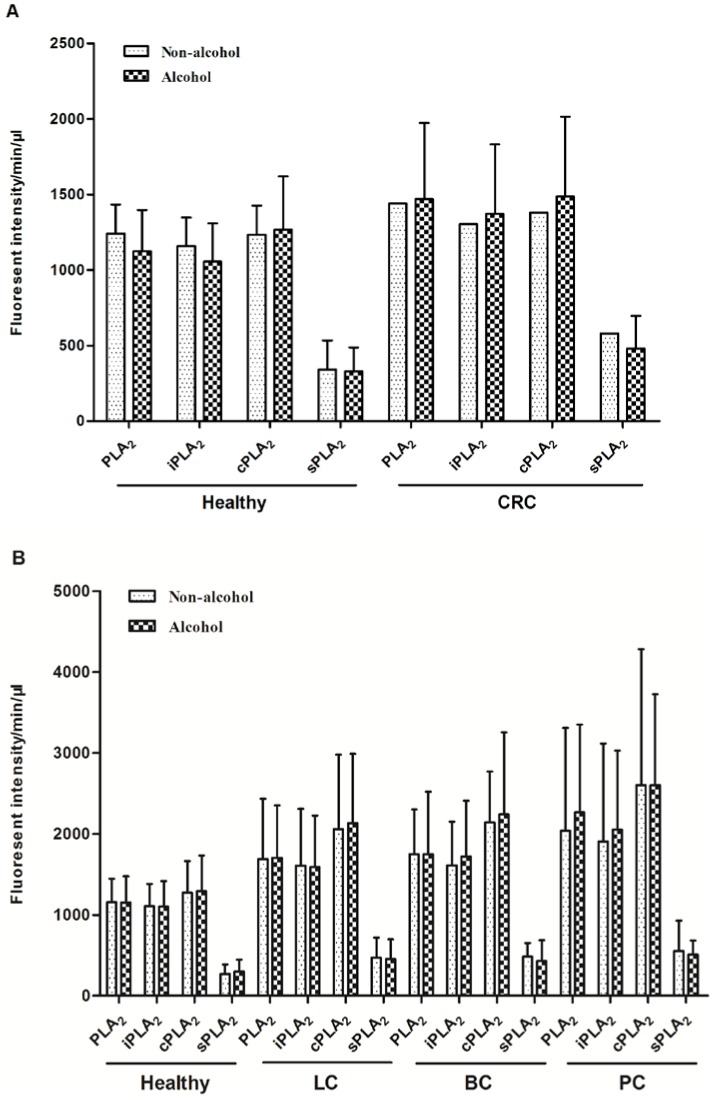
The influence alcohol consumption on plasma PLA2 activities.Comparison of PLA2 activities between “non-alcohol” and “alcohol” groups with the healthy and CRC participants. A. Comparison of PLA2 activities between “non-alcohol” and “alcohol” groupsin the second set of studies with healthy, LC, BC, and PC participants.